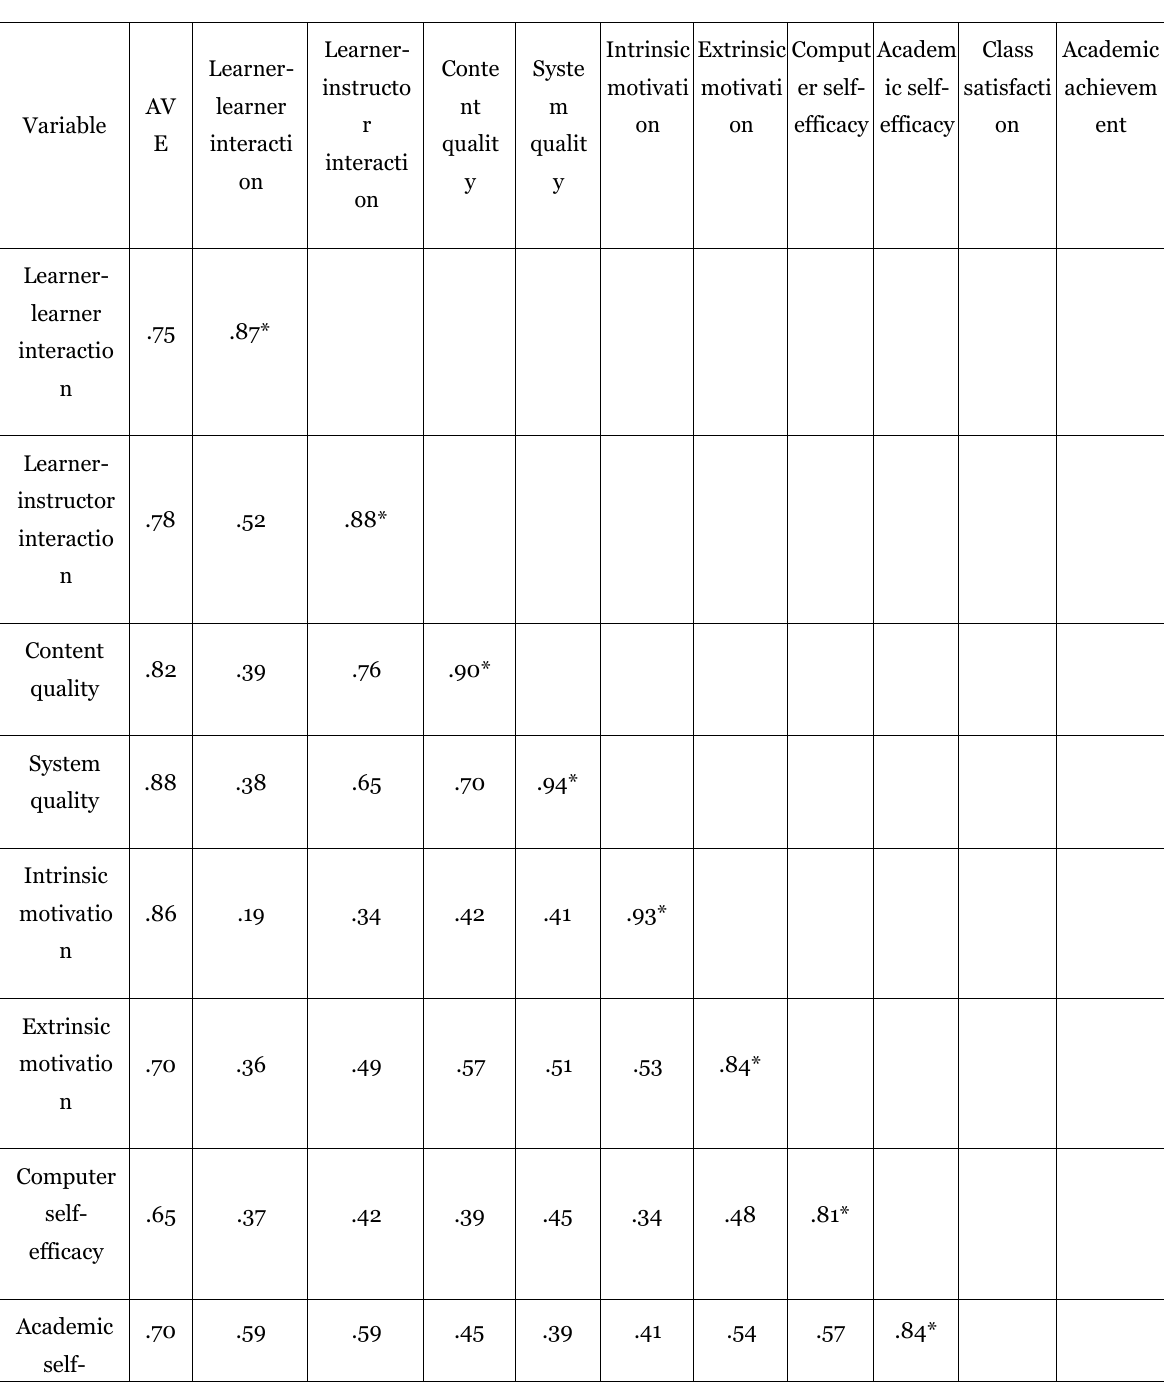
Correlation Matrices and Discriminant Validity Among